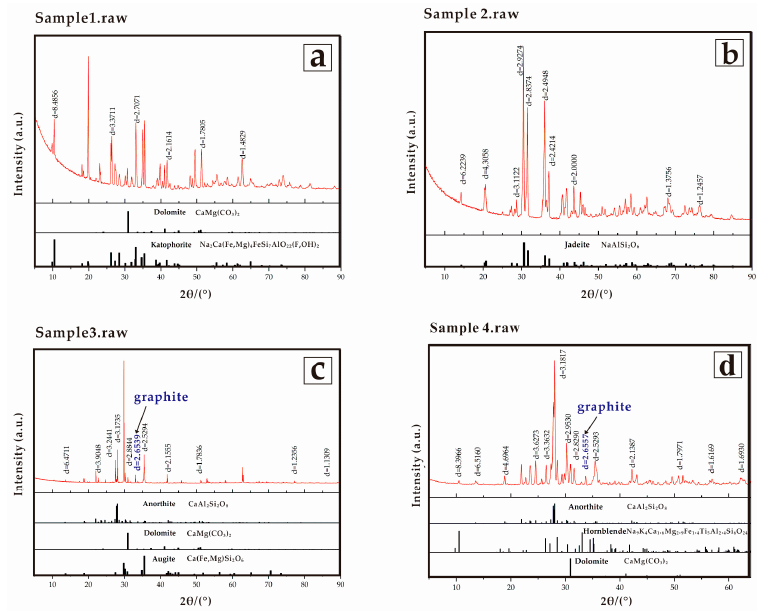
Figure 3. X-ray powder diffraction patterns of ( a ) Sample 1; ( b ) Sample 2; ( c ) Sample 3 and ( d ) Sample 4.